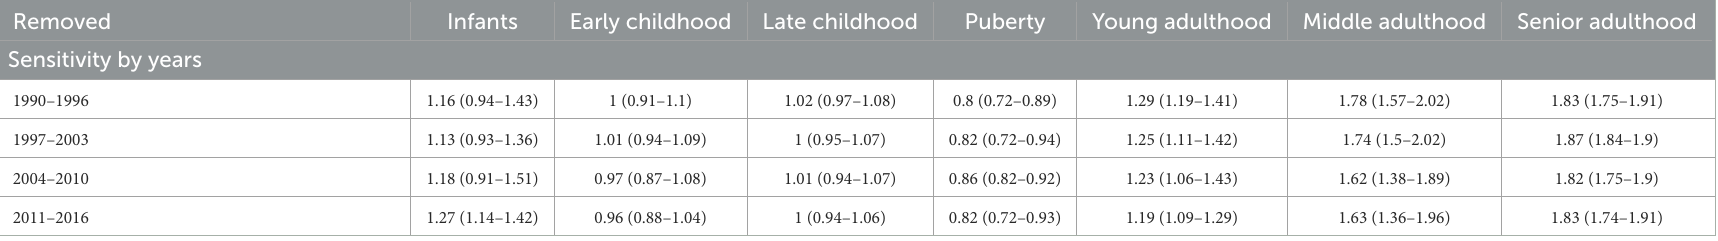
TABLE 2 Sensitivity analysis by years (after excluding group of years at a time).